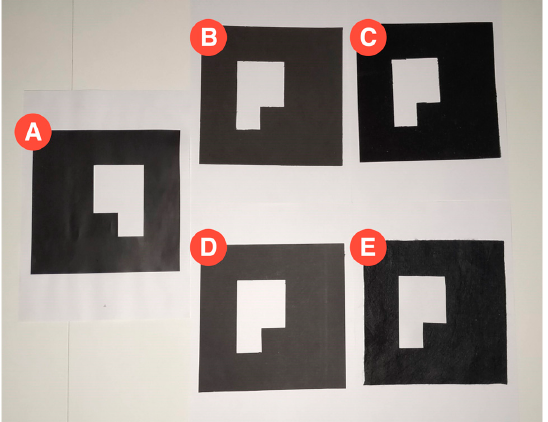
Figure 3. Comparison of five markers made of five different materials, under direct artificial white LED light. Whilst the marker ( A ) was printed, the others were cut and glued to standard printing paper. The other black materials are ( B ) EVA (ethylene-vinyl acetate) foam sheet, ( C ) velvet paper, ( D ) plain cardboard, and ( E ) felt sheet.